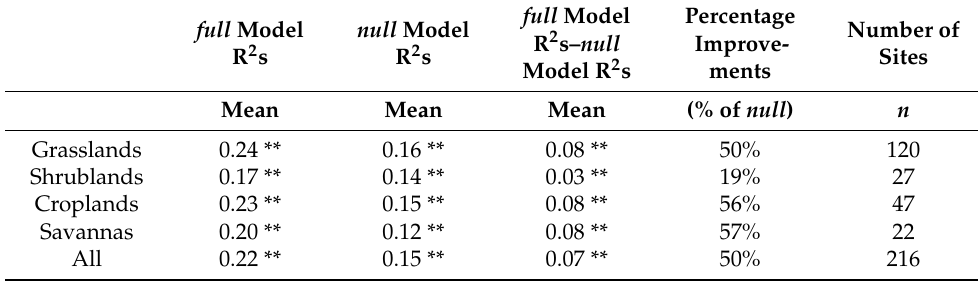
Table 2. Statistics of “ null ” model ubRMSE and “ full ” model ubRMSE for LAI anomaly predictions and the statistics of the difference in ubRMSE between the “ full ” models and “ null ” models and for the LAI anomaly predictions or LAI predictions (asterisks indicate the ubRMSE of the models are significantly greater than 0 with different significant levels * 0.05; ** 0.01. Note: This table is the same for LAI predictions due to how we reconstruct LAI using the “ full ” model and “ null ” model predicted LAI anomalies combined with static LAI climatology).